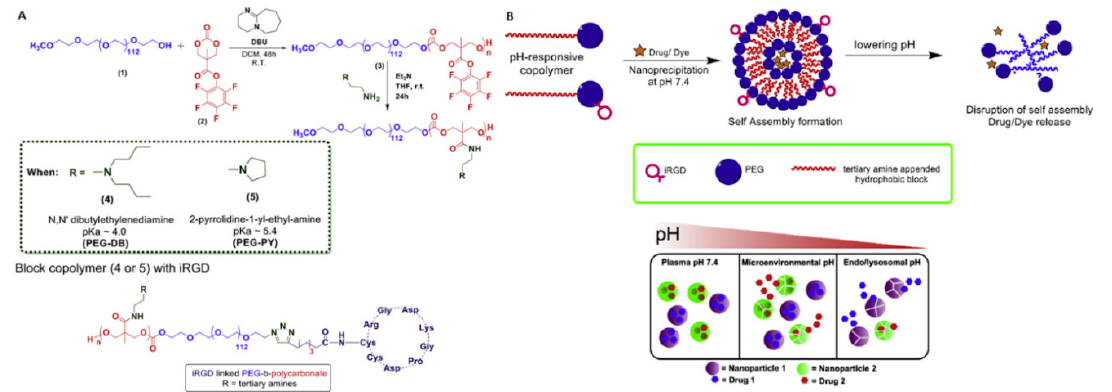
Figure 4. ( A ) Synthetic route to pH-responsive PEGylated polycarbonate copolymers and their iRGD conjugated variant. ( B ) ( Top ) Schematic illustration of self-assembly of pH-responsive copolymers and ( bottom ) mixed micelle system for pH-selective drugs release. Reprinted with permission from